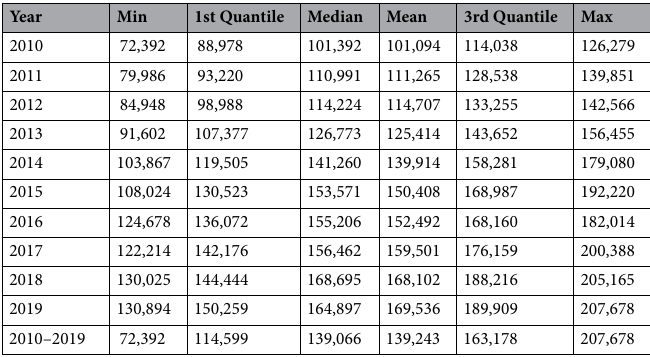
Table 1. Descriptive statistics on monthly air traffic data using Turkish airspace between 2010 and 2019.